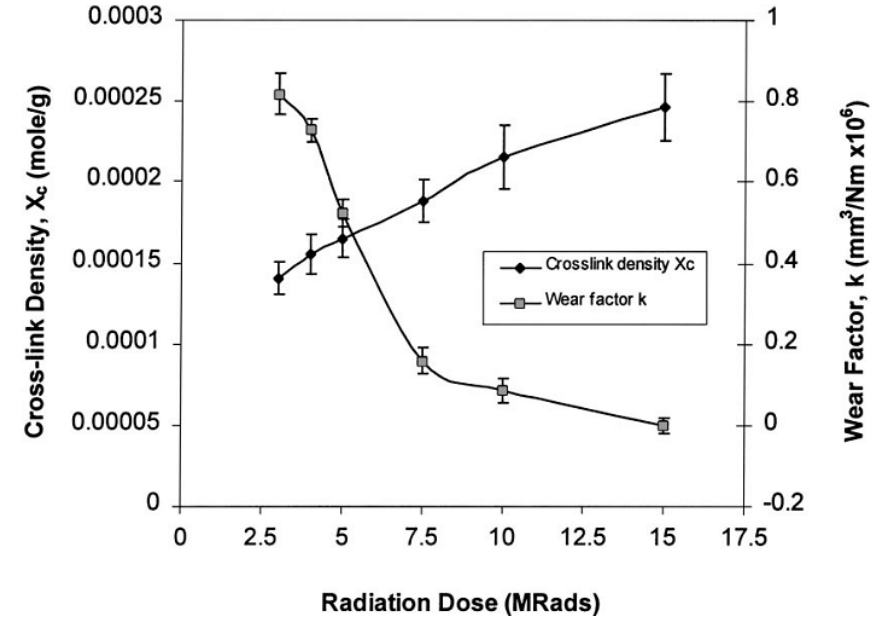
Figure 5. The COF of UHMWPE for different aging times. Reprinted with permission from [94].